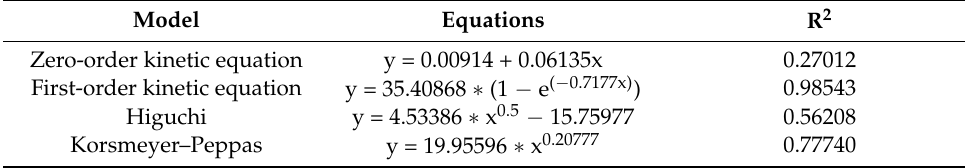
Table 1. Cumulative release curve fitting results of CE-NE in vitro (pH 4.0).